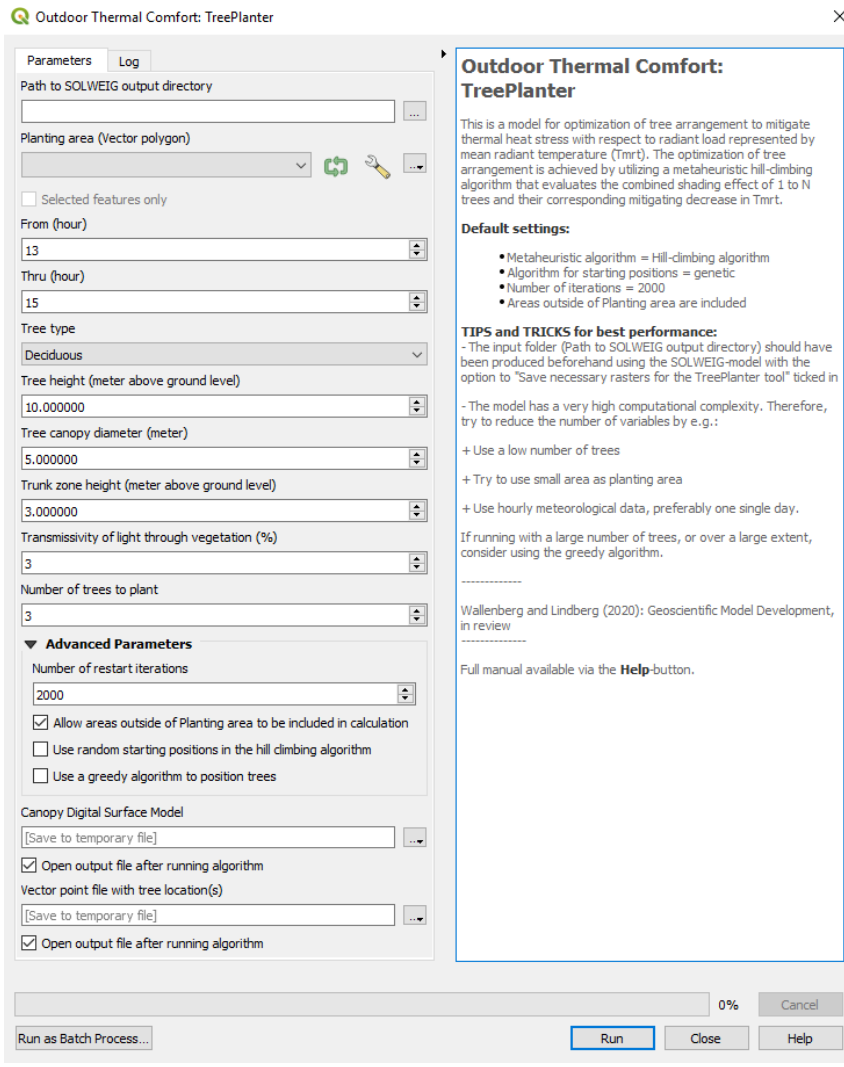
Figure 12. Graphical user interface of the TreePlanter 1.0 in